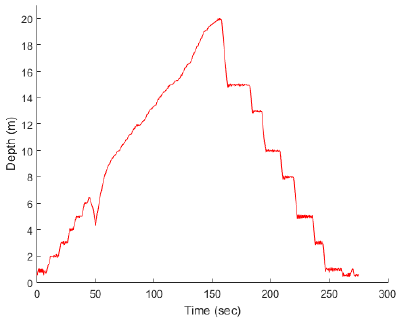
Figure 13. TUP depth control results.